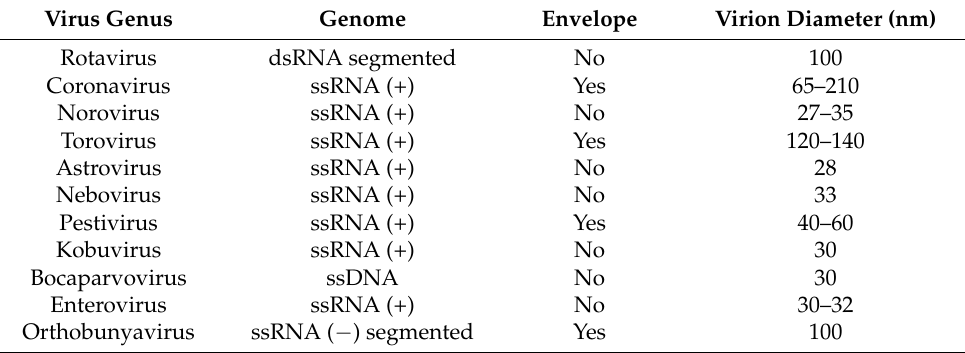
Table 1. Main characteristics of the viruses